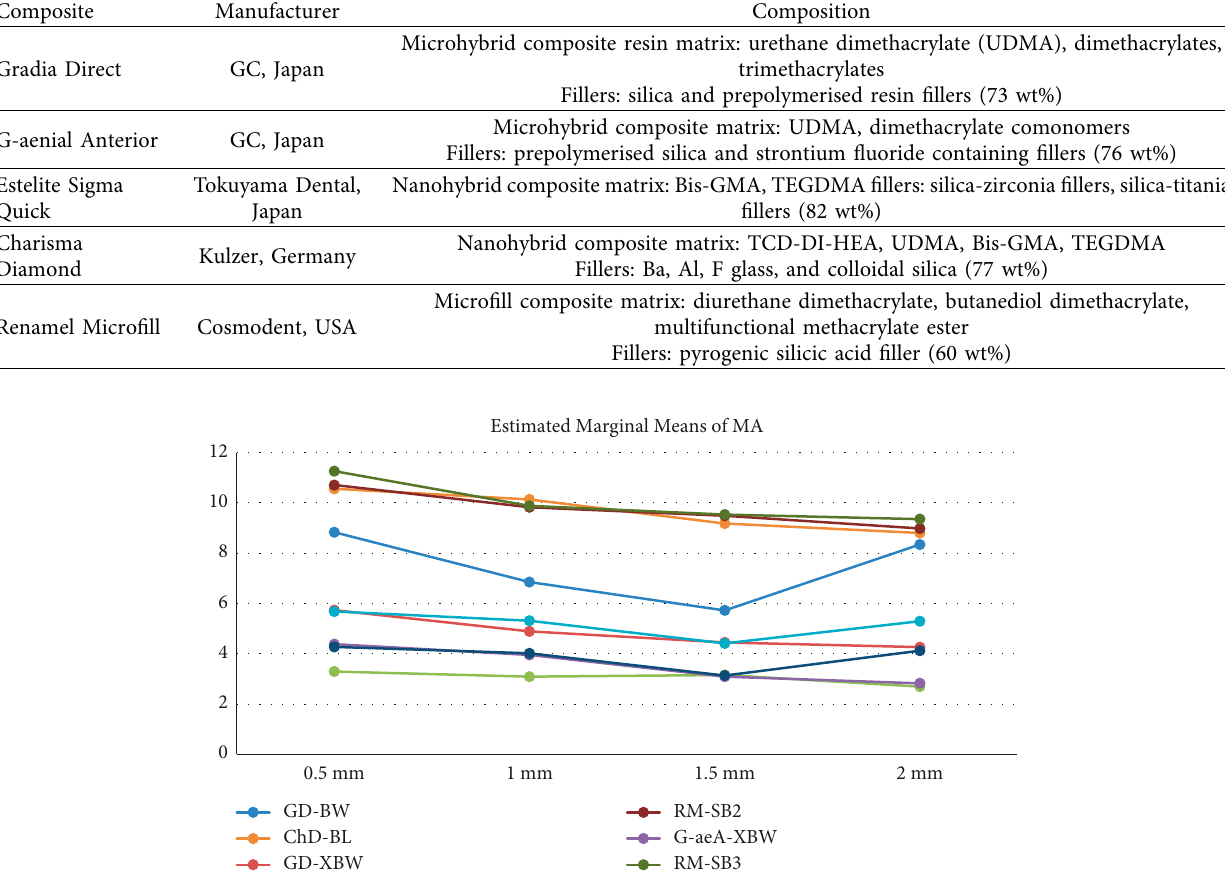
Figure 1: MA of different groups.